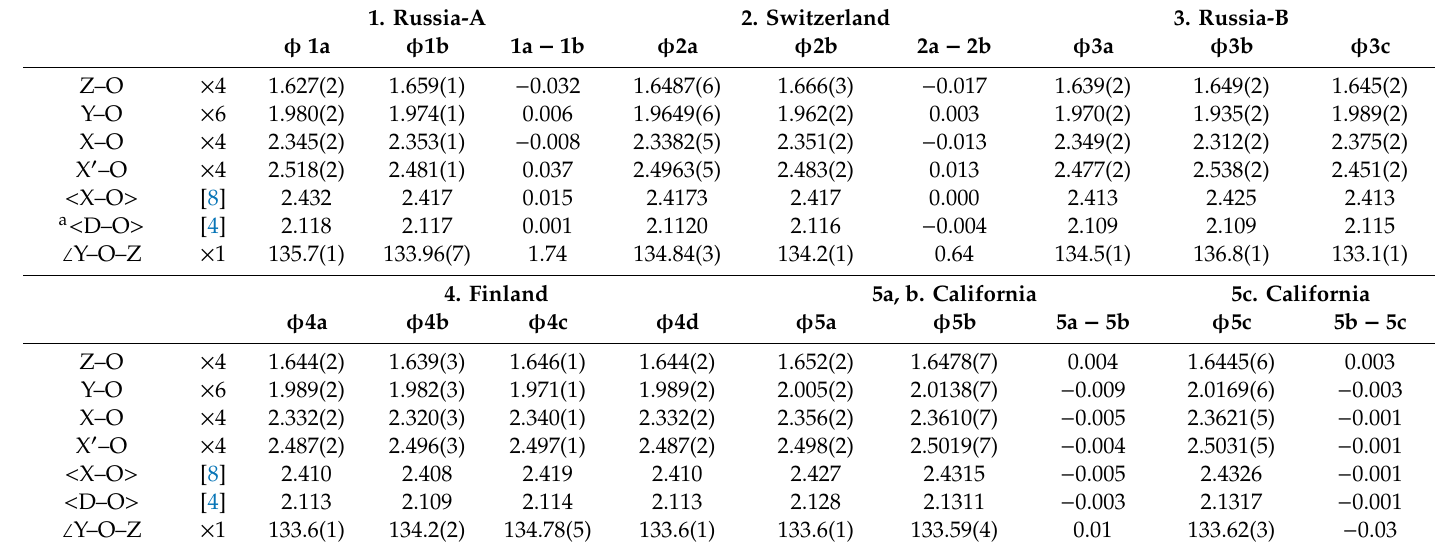
Table 5. Selected bond distances (Å) and angles ( ◦ ) for five uvarovite